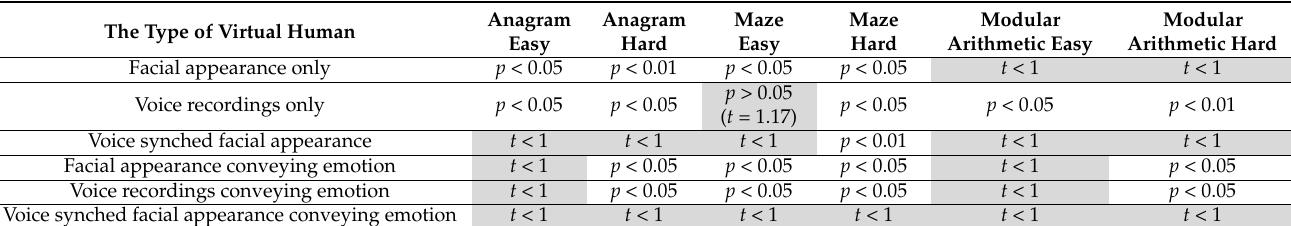
Table 2. Post hoc analyses for each virtual human